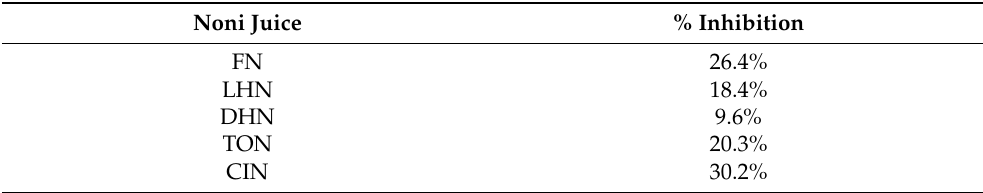
Table 5. Acetylcholinesterase (AChE) inhibitory activity of the neat noni juice samples. Values are given as the percentage of total inhibition.